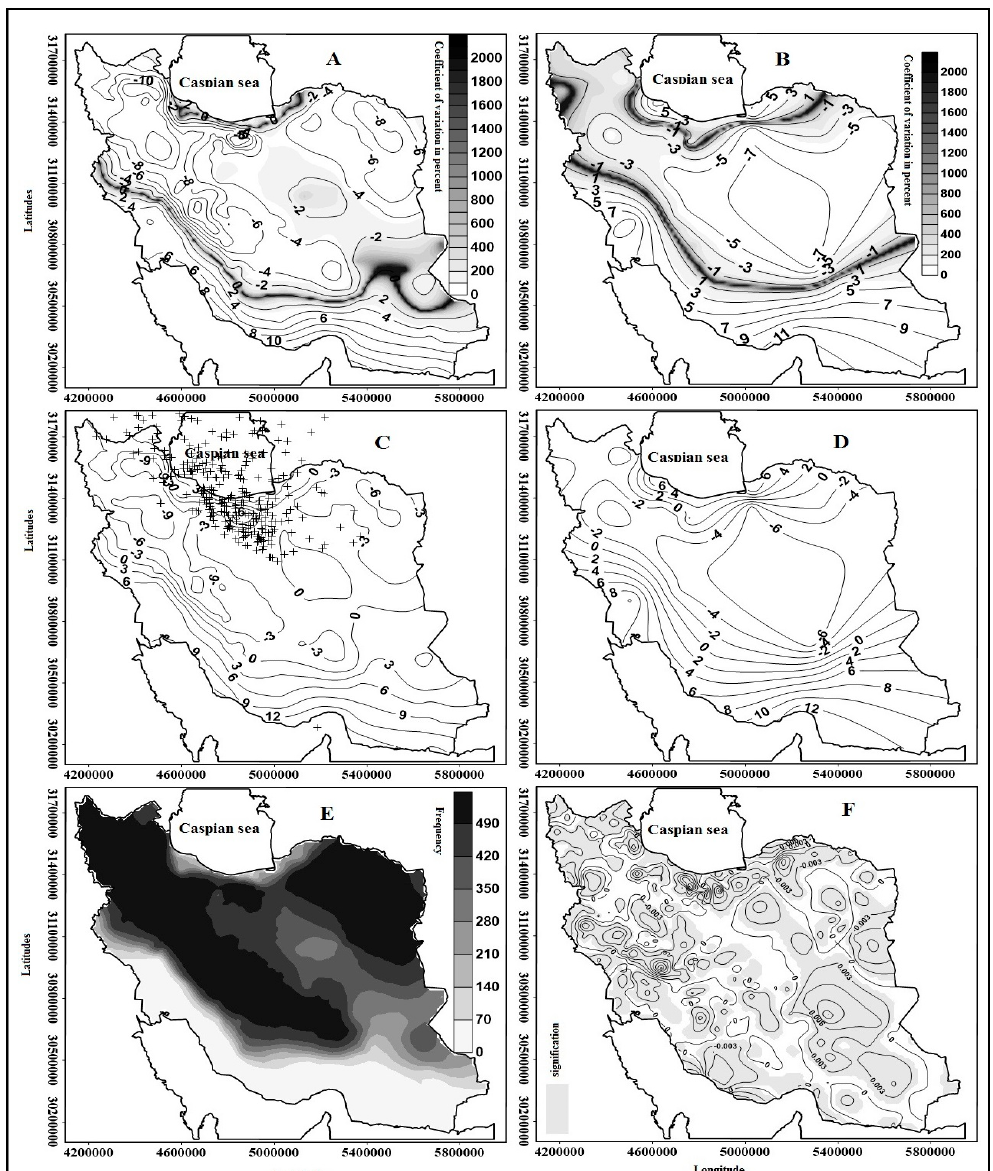
Figure 12. The fifth pattern: ( A ) Spatial distribution of temperature average and coefficient of variation for the whole group; ( B ) spatial distribution of temperature average and coefficient of variation for the representative day; ( C ) anomalies and center of masses for the whole group; ( D ) anomalies for the representative day; ( E ) frequency of frosts for the whole group; and ( F ) spatial distribution of the trend of Iran’s frosts for the whole group.